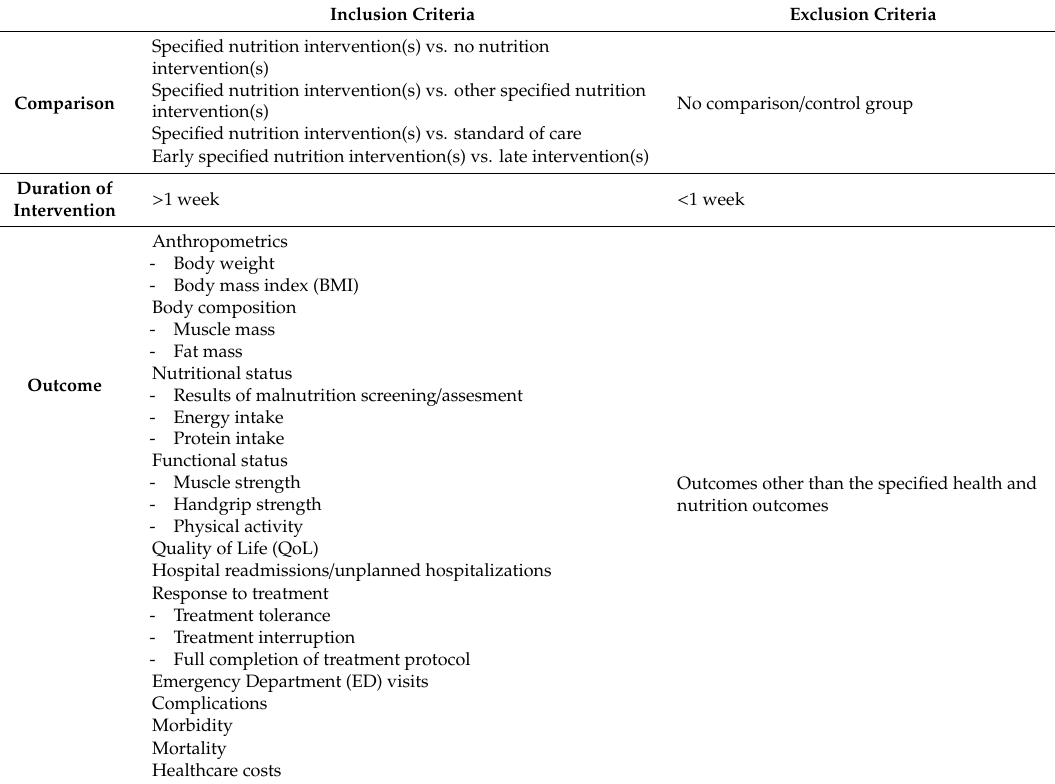
Table 3. Reviewers met after the screening and full-text assessment steps to discuss all studies and reach an agreement on studies for final